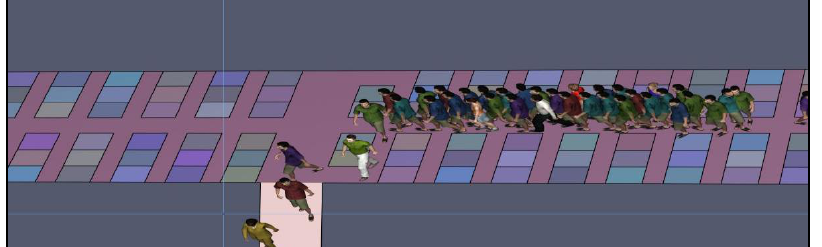
Figure 5 – Simulation moment for the third case of the first scenario at 88 seconds after the start of the simulation